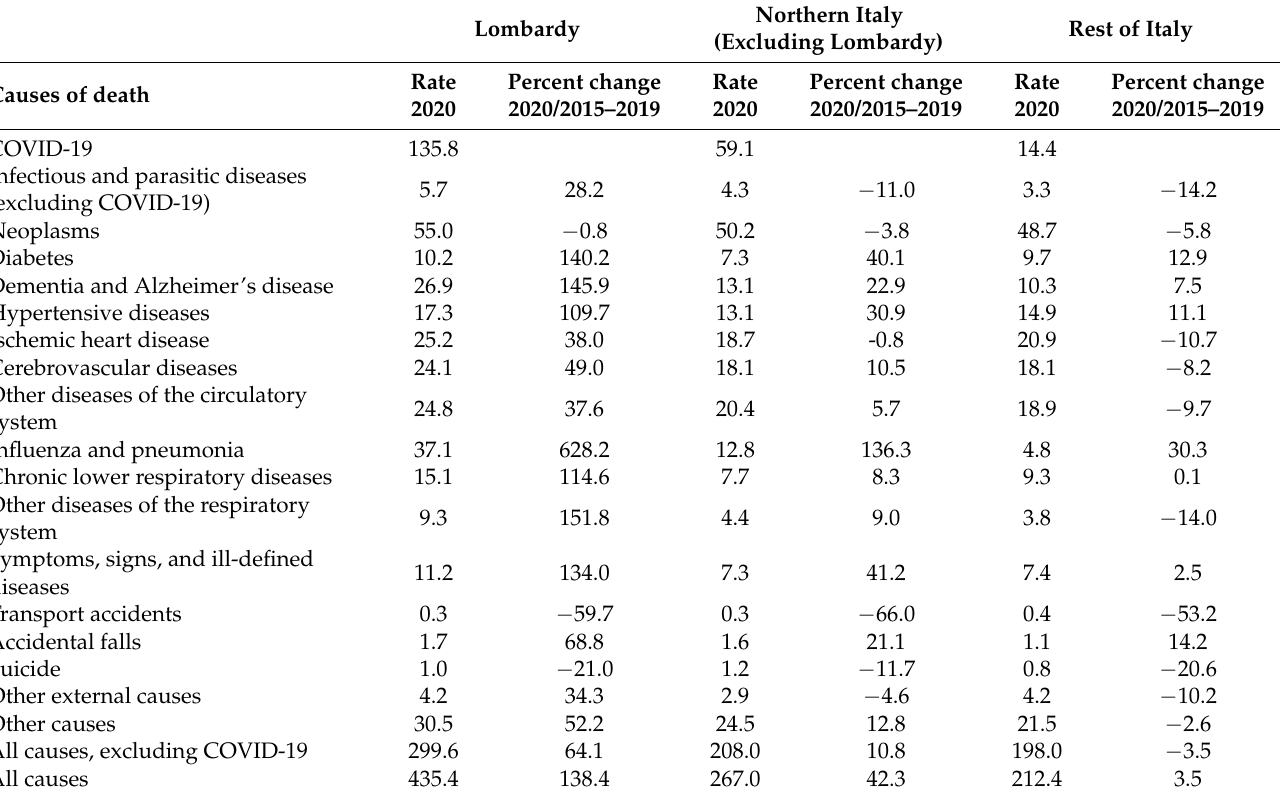
Table 3. Mortality by cause in Italy from March 2020 to April 2020, by geographical area of residence: age-standardized mortality rates (values per 100,000 residents) and percent change in rates compared with those in